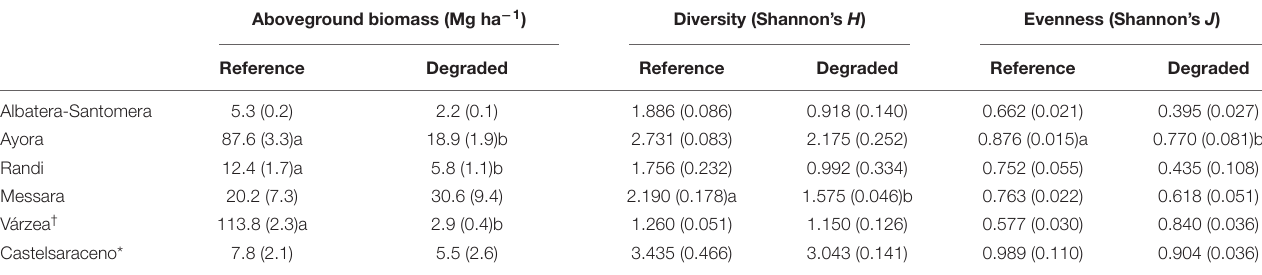
TABLE 2 | Plant biomass and diversity indexes (mean values and standard errors in brackets) in the undisturbed and degraded states of the six CASCADE field sites, ordered from most to least